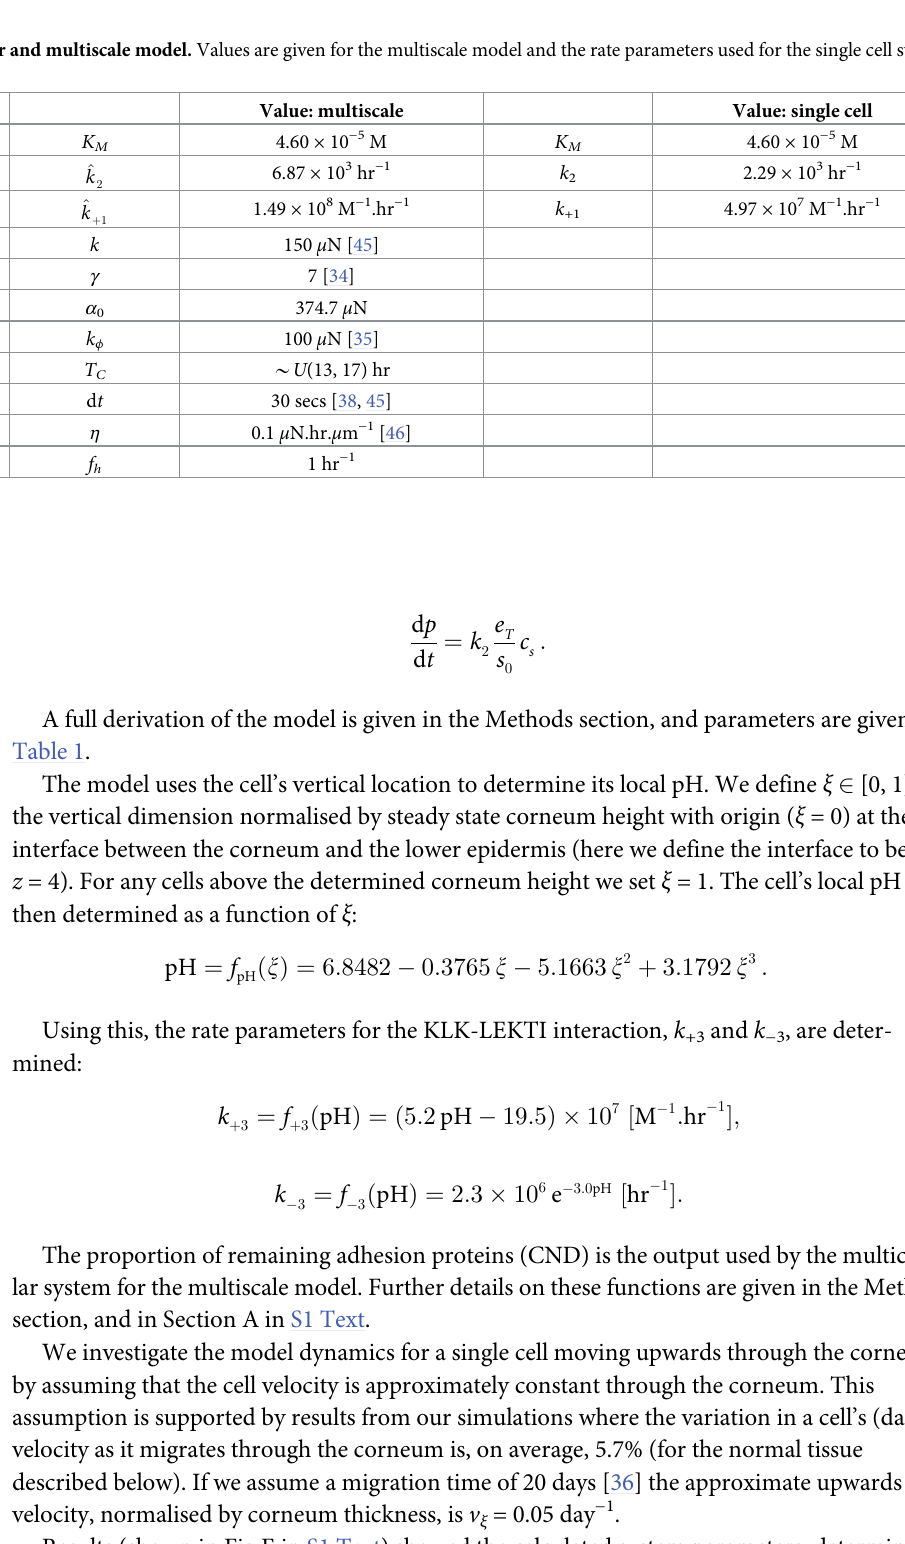
The proportion of remaining adhesion proteins (CND) is the output used by the multicellu- lar system for the multiscale model. Further details on these functions are given in the Methods section, and in Section A in S1 Text.